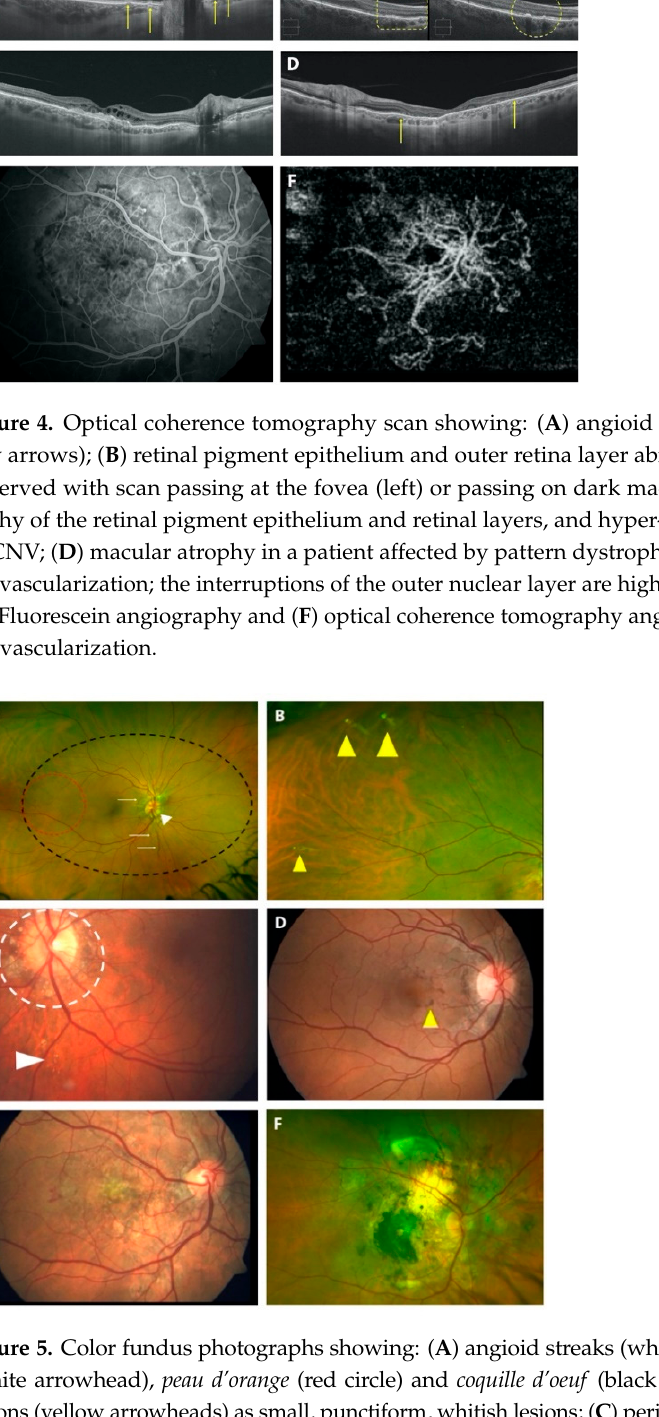
Figure 5. Color fundus photographs showing: ( A ) angioid streaks (white arrows), optic disc drusen (white arrowhead), peau d’orange (red circle) and coquille d’oeuf (black circle); ( B ) peripheral comet lesions (yellow arrowheads) as small, punctiform, whitish lesions; ( C ) peripapillary comet lesions (white circle) and comet rain (white arrowheads); ( D ) pattern dystrophy-like changes classified as “ fundus pulverulentus ” (yellow arrowhead); ( E ) choroidal neovascularization; ( F ) posterior pole at- rophy.